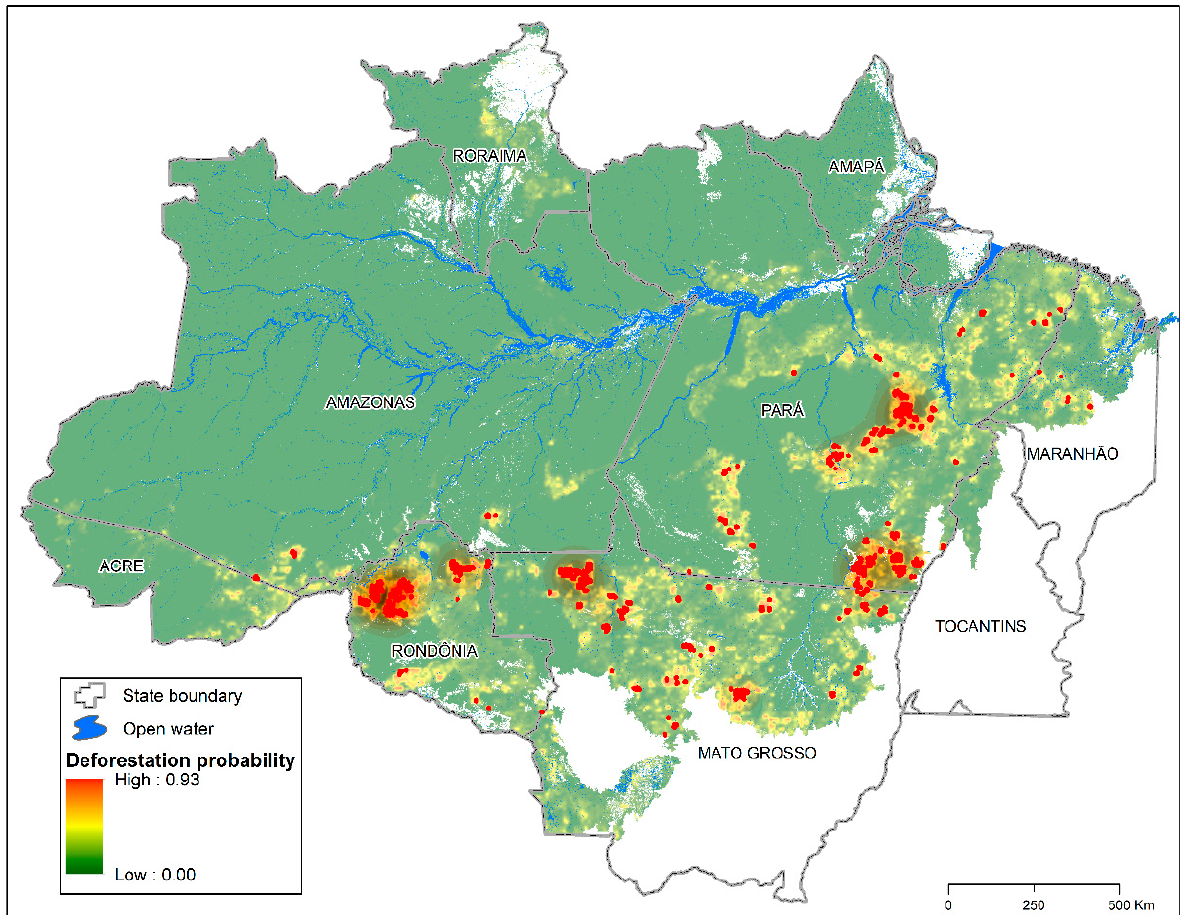
Figure 6. Hotspots of predicted deforestation in the Brazilian Amazon biome. Note: Predicted deforestation raster cells were converted to points for better cartographic display.